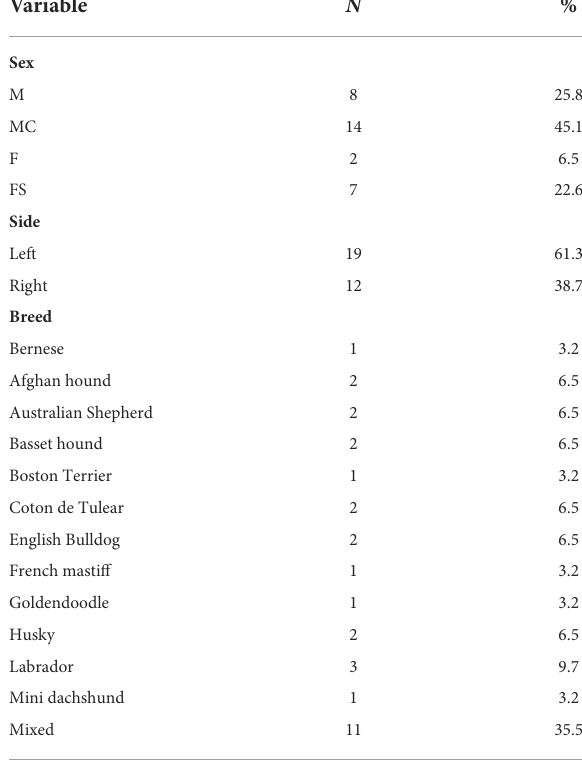
TABLE 2 Mean and standard deviations for age and weight of the treated animals.